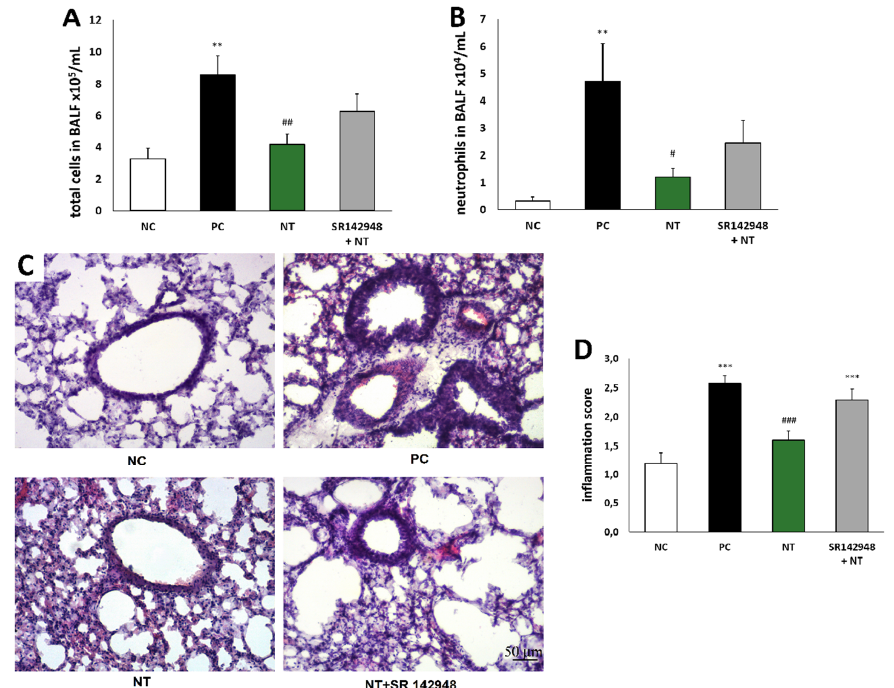
Figure 2. Reduction of the total number of inflammatory cells ( A ) and neutrophils ( B ) in bronchoalveolar lavage fluid (BALF) and effect of NT on lung tissue inflammatory cell infiltration; hematoxylin- and eosin-stained lung sections ( C ) and inflammation score ( D ); see Materials and Methods 4.9. Effect of treatment with NT alone and NT pretreated with SR 142948 in comparison to DNFB-sensitized/DNS-challenged group (positive control; PC) and